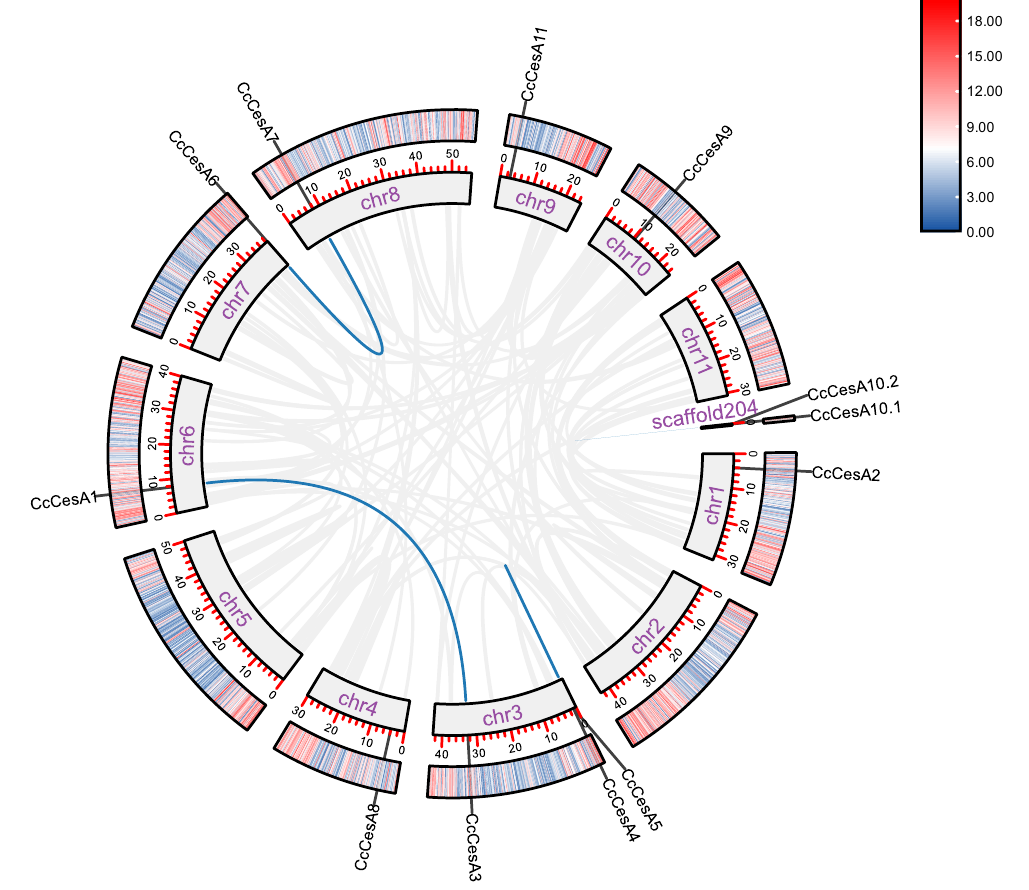
Figure 2. CcCesA chromosomal localization and tandem duplication events in the C. citriodora genome. The 11 chromosomes are plotted along with an Mb (million base pair) scale. A heat map shows the gene density of chromosomes. The blue line shows the homologous genes that are collinear. Gray lines indicate collinear blocks in the whole C. citriodora genome.